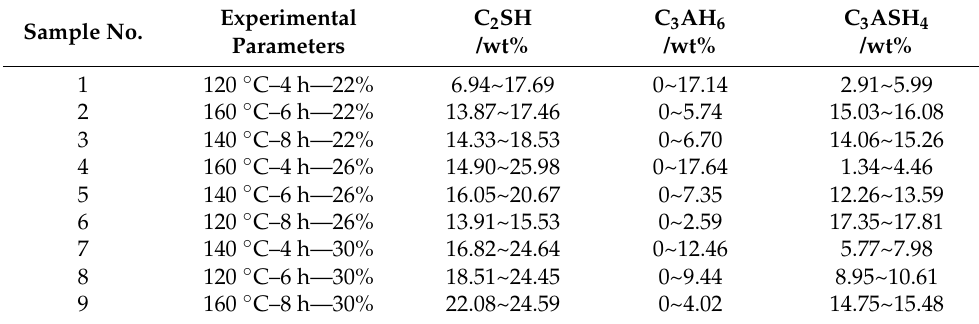
Table 5. Content of hydration products of different autoclaved samples. Sample